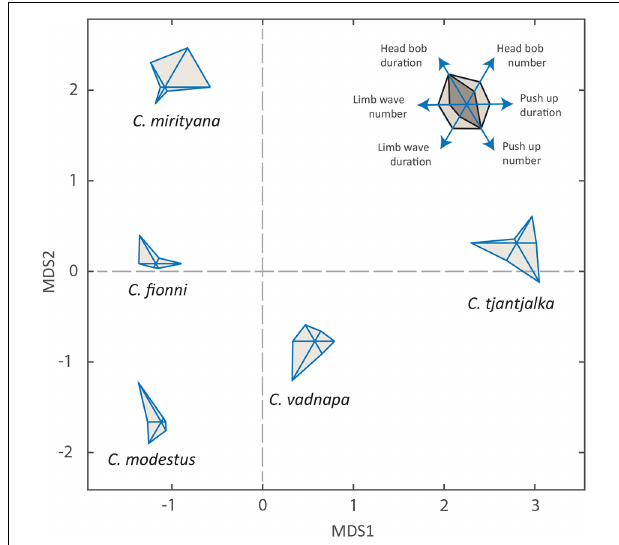
FIGURE 4 | Glyph plots and multidimensional scaling showing the level of similarity between the five study species based on six variables: head bob mean duration, head bob total number, push up mean duration, push up total number, limb wave mean duration and limb wave total number. Inset Mapping of each variable to points on the glyph plot, with two hypothetical examples: the darker shade is equivalent to the lighter shade in head bob duration and number of push ups, but performs half the number of head bobs and leg waves, and spends half as long on push ups and leg